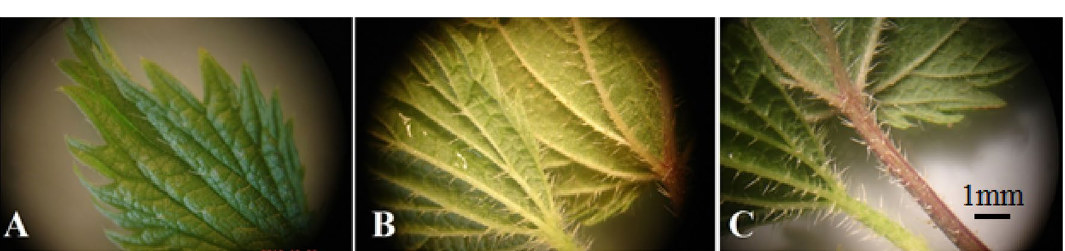
Figure 4. The wild habitat of a mountainous nettle ( A ) and the same plant under pot growth conditions ( B ).